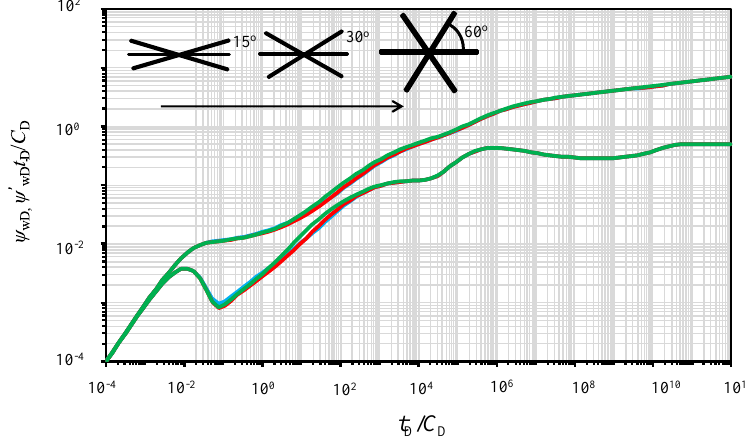
Figure 11. Effect of hydraulic fracture angle symmetry on the PPR and PPD.